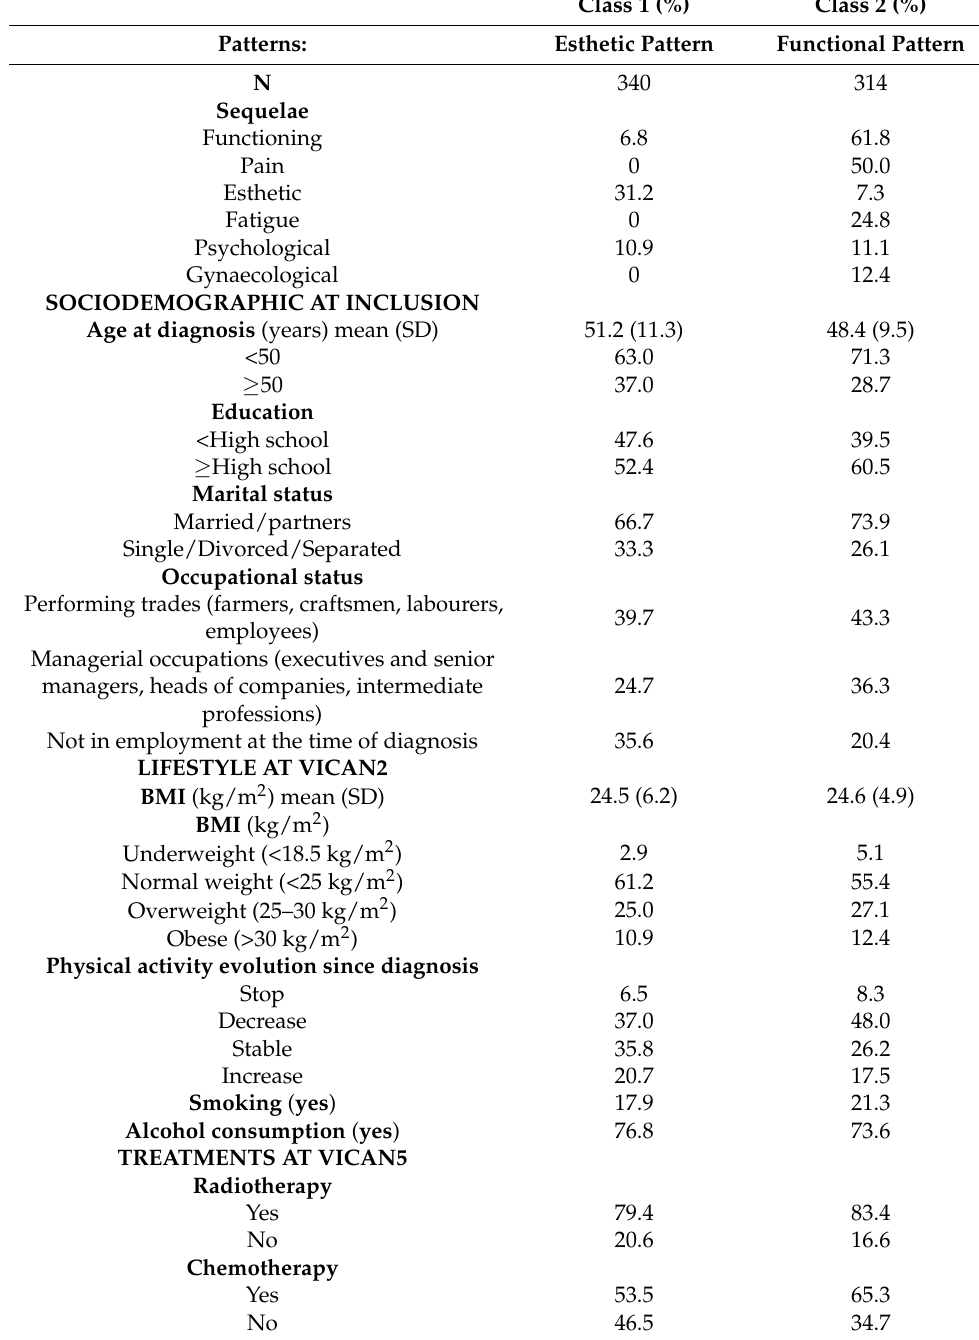
Table 3. Characteristics of the two latent classes model among patients with breast cancer (BC) ( n = 654).